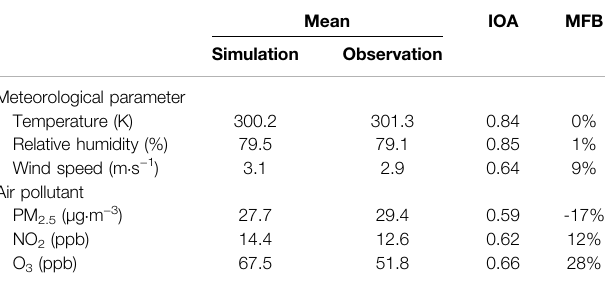
TABLE 1 | Model performance in predicting meteorological parameters and air pollutants over the YRD region during the study